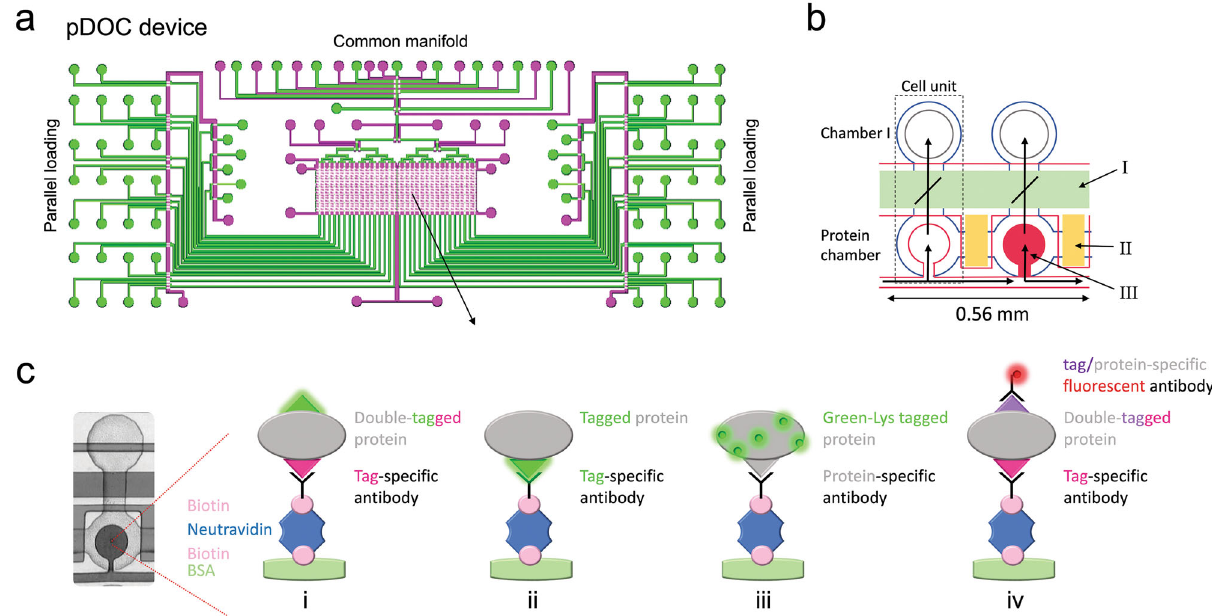
Fig. 1 Design and strategy toward protein degradation assay on-chip. a pDOC is a MITOMI-based micro fl uidic platform. The device includes fl ow (green) and control (Magenta) layers, and several modules: 1) common manifold enabling loading of materials, which in combination with microarray can enable